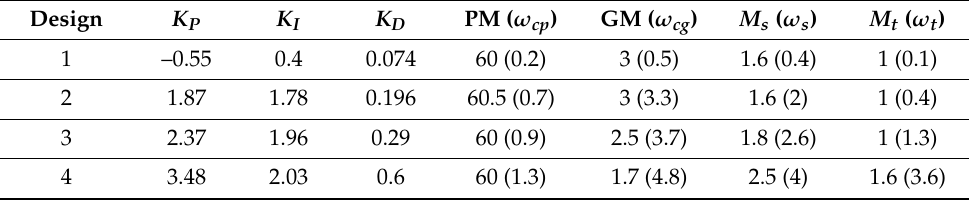
Table 5. PID designs and achieved specifications.